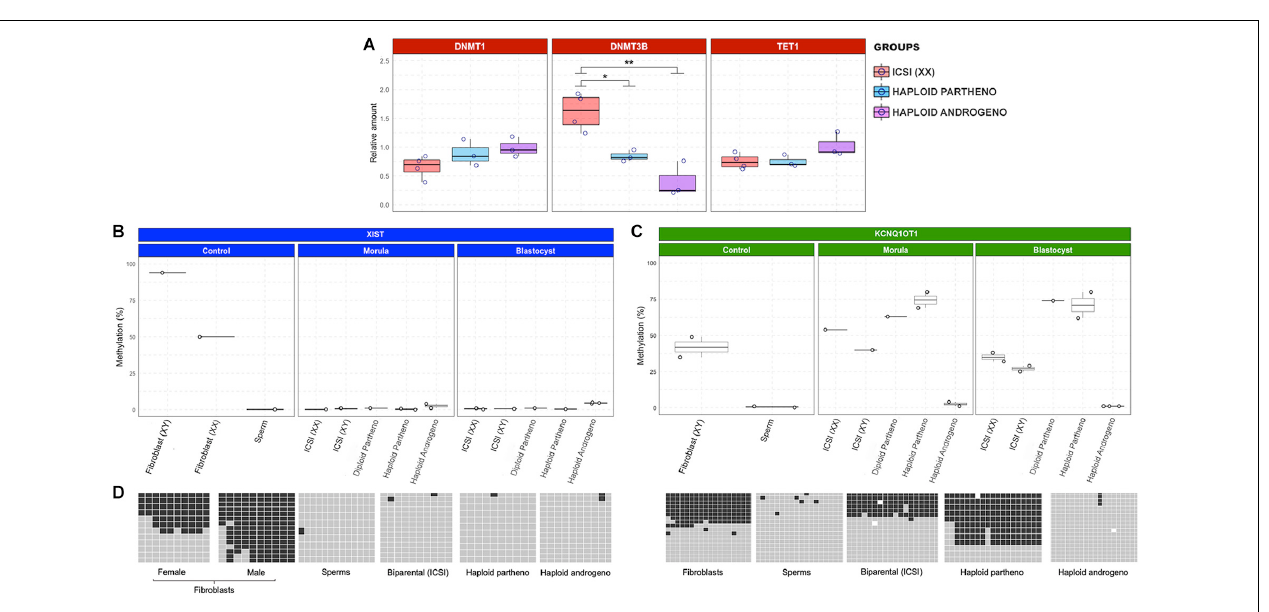
FIGURE 9 | Relative transcript levels of DNA methylation-related enzymes and DNA methylation profiles of XIST and KCNQ1 DMR. (A) Relative transcript levels of DNMT1, DNMT3B, and TET1 in biparental diploid female (ICSI), haploid parthenogenetic and androgenetic embryos. (B) DNA methylation profiles of XIST and (C) KCNQ1 DMR in morula (pool of two embryos) and blastocyst (individual embryo) stages. Each point represents one biological replicates. (D) Representative image depicting the gene specific DNA methylation patterns of XIST and KCNQ1 DMR in somatic cells (fibroblast), sperm, and embryos. Fibroblast (XX), female fibroblast cells; Fibroblast (XY), male fibroblast cells; ICSI (XX), intracytoplasmic sperm injection using X chromosome sorted-sperm; ICSI (XY), intracytoplasmic sperm injection using male sorted-sperm; haploid partheno: haploid parthenogenetic embryo obtained by oocyte activation using ionomycin followed